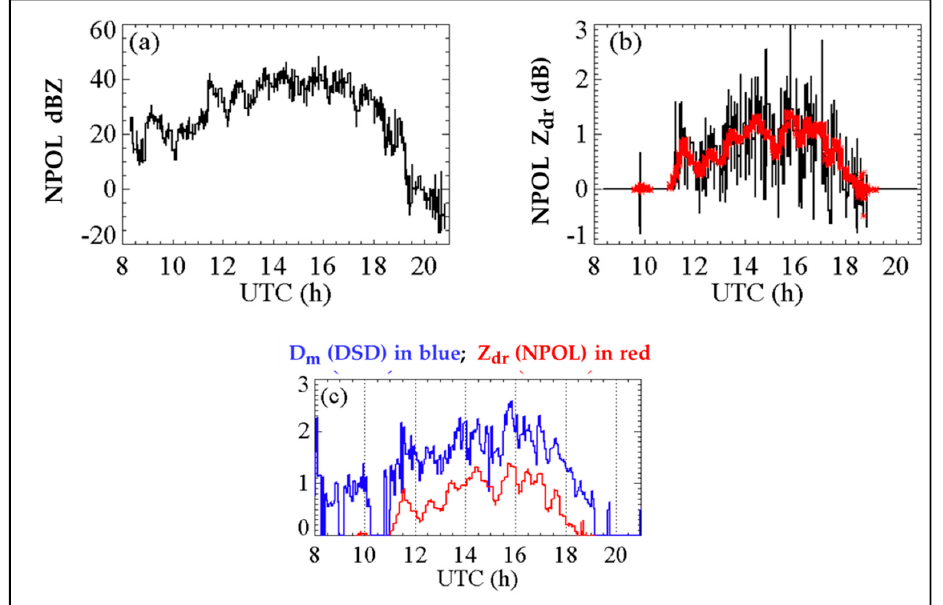
Figure 7. Extracted ( a ) Z h and ( b ) Z dr over and around disdrometer site from 400 to 600 m above sea level. Red line in ( b ) shows Lee-filtered Zdr. ( c ) Same red line as ( b ) and mass-weighted mean diameter (blue) from 3 min composite DSDs.